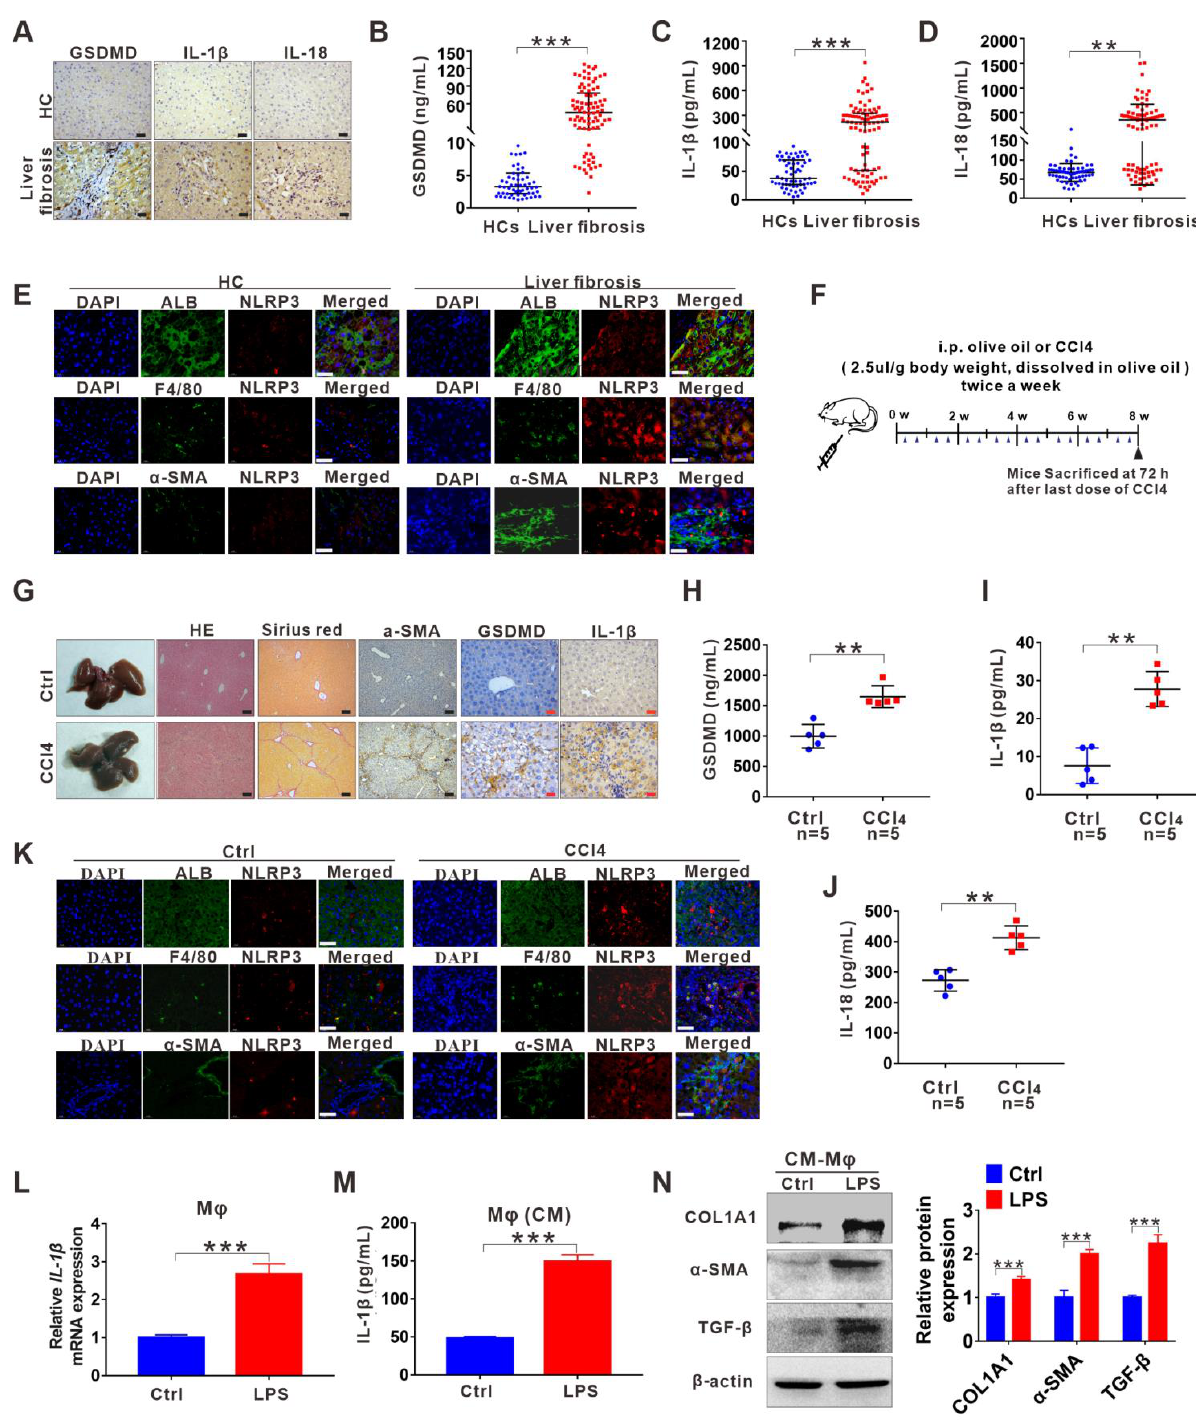
Figure 1. NLRP3 inflammasome-dependent pyroptosis occurs in liver fibrosis. ( A ) IHC staining Figure 1 . NLRP3 inflammasome-dependent pyroptosis occurs in liver fibrosis. (A) IHC staining for GSDMD, IL- 1β, and IL -18 in liver sections from liver fibrosis patients and HCs. Scale bar: 40 µm. (B – D) ELISA analyses of serum levels of GSDMD (B) , IL- 1β (C) , and for GSDMD, IL-1 β , and IL-18 in liver sections from liver fibrosis patients and HCs. Scale bar: IL-18 (D) in liver fibrosis patients ( n = 89) and HCs ( n = 60). (E) Representative immunofluorescence images of NLRP3 (red) and 40 µ m. ( B – D ) ELISA analyses of serum levels of GSDMD ( B ), IL-1 β ( C ), and IL-18 ( D ) in liver fibrosis patients ( n = 89) and HCs ( n = 60). ( E ) Representative immunofluorescence images of NLRP3 (red) and albumin (hepatocyte marker) (top), F4/80 (KC marker) (middle) or α -SMA (HSC marker) (bottom) (green) from the human fibrotic liver tissues. Scale bar: 40 µ m. ( F ) Schematic diagram of the study. Liver fibrosis was induced by CCl4 injection for 8 weeks. ( G ) Representative mouse liver histology of H&E, Sirius Red staining, and IHC staining for α -SMA, GSDMD, and IL-1 β . Black